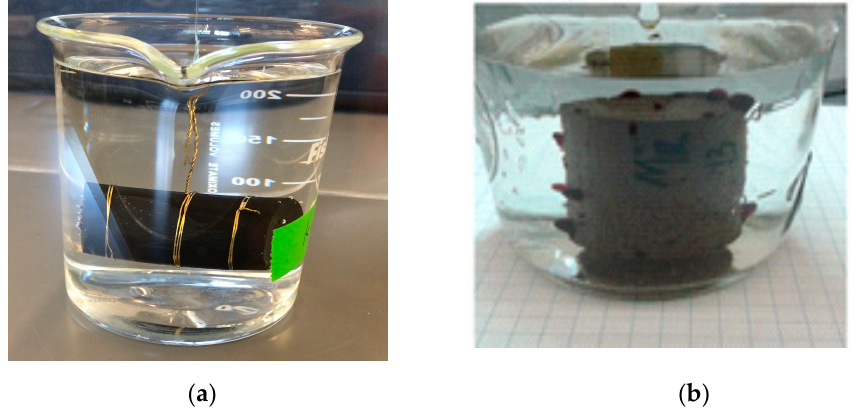
Figure 1. Two typical spontaneous imbibition experiments ( a ) measuring sample weight change by hanging on the balance; ( b ) measuring fluid volume change in imbibition vessel.